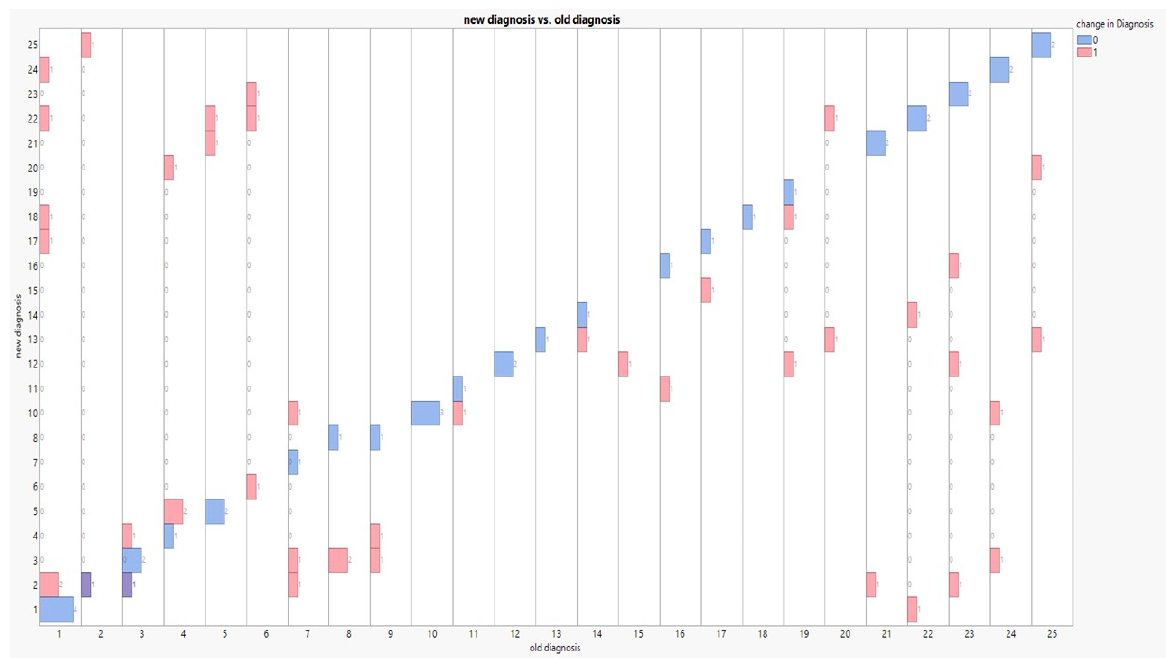
Figure 3. Graphical cross-tabulation between old and new diagnoses as affected by change in diagnosis (0.1). Red bars: changes; Blue bars: no changes.